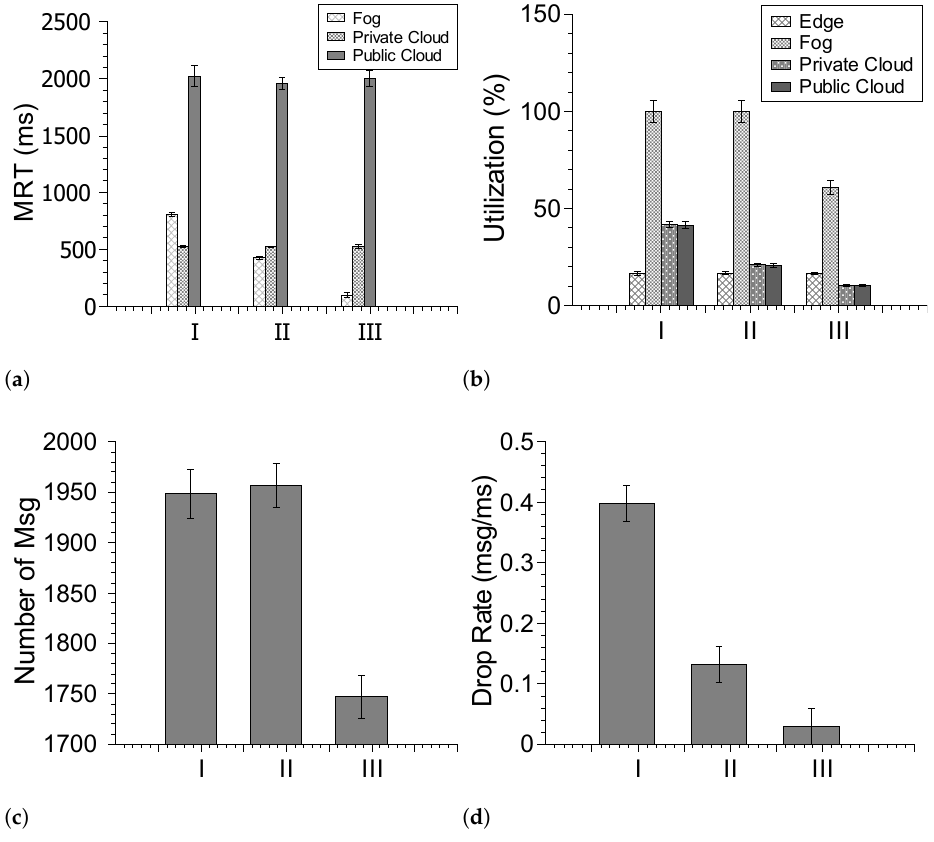
Figure 8. Model numerical results considering the variation of the number of cores per node. ( a ) Mean response time. ( b ) Utilization. ( c ) System number of messages. ( d ) Drop